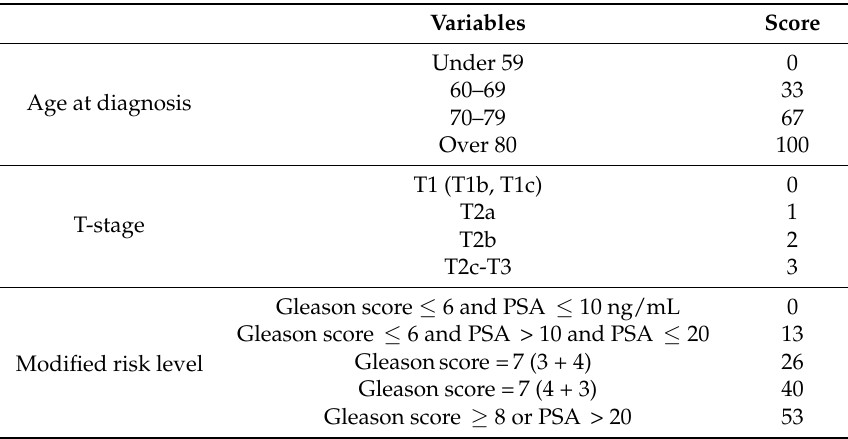
Table 3. Prostate Clinical Outlook (PCO) classifier application